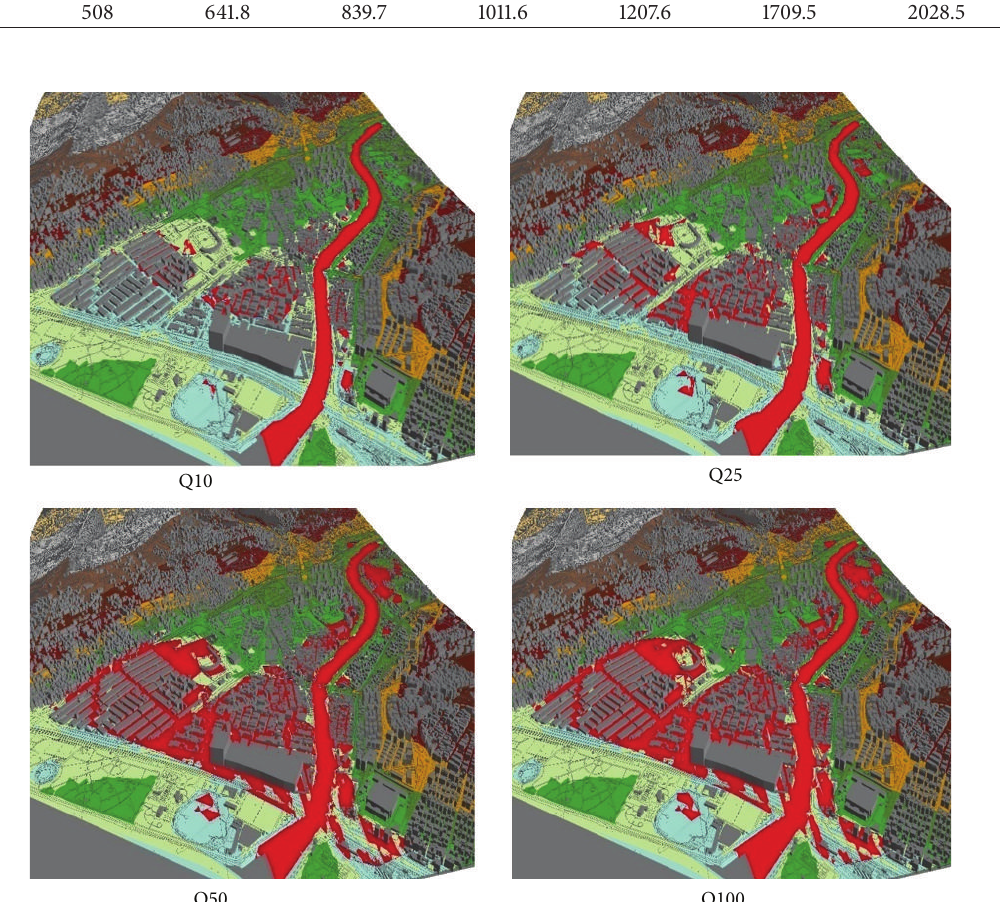
Figure 4: 3D hazard maps of the Mert River obtained for the Q10, Q25, Q50, and Q100 floods.